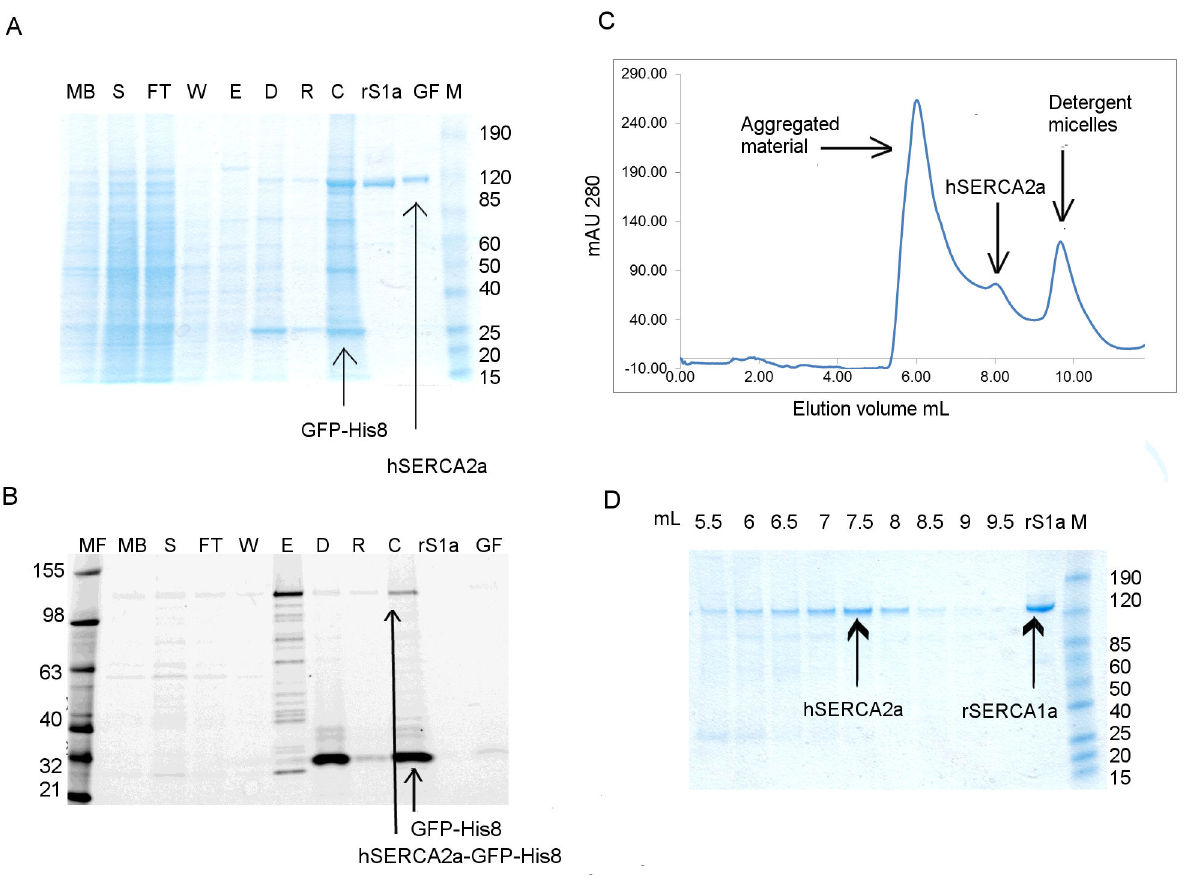
Figure 3. Purification of h SERCA2a-GFP-His using Ni-NTA affinity chromatography. Purification was done in the presence 8 of DDM only throughout all steps, including SEC. Protein was obtained using rich media. A . Coomassie stained SDS-PAGE gel; B . In gel fluorescence 12% Tris-Glycine SDS-PAGE gel. MF- fluorescent protein ladder; MB- diluted membrane fraction; S- solubilised fraction; FT- flow-through after binding; W- wash fraction; E- elution; D- sample after cleavage with TEV protease and dialysis; R- sample after Ni-NTA rebinding after tag cleavage; C- sample concentrated using 50 kDa cut-off filter concentrator, before gel filtration; S1a- rabbit SERCA1a; GF- fraction containing human SERCA2a after gel filtration; M- prestained protein ladder. C . HPLC- SEC profile for h SERCA2a purified using Ni-NTA super-flow resin. D . Coomassie stained 4-12% Tris-Glycine SDS PAGE gel for SEC fractions obtained for purification of h SERCA2a using Ni-NTA super-flow resin.